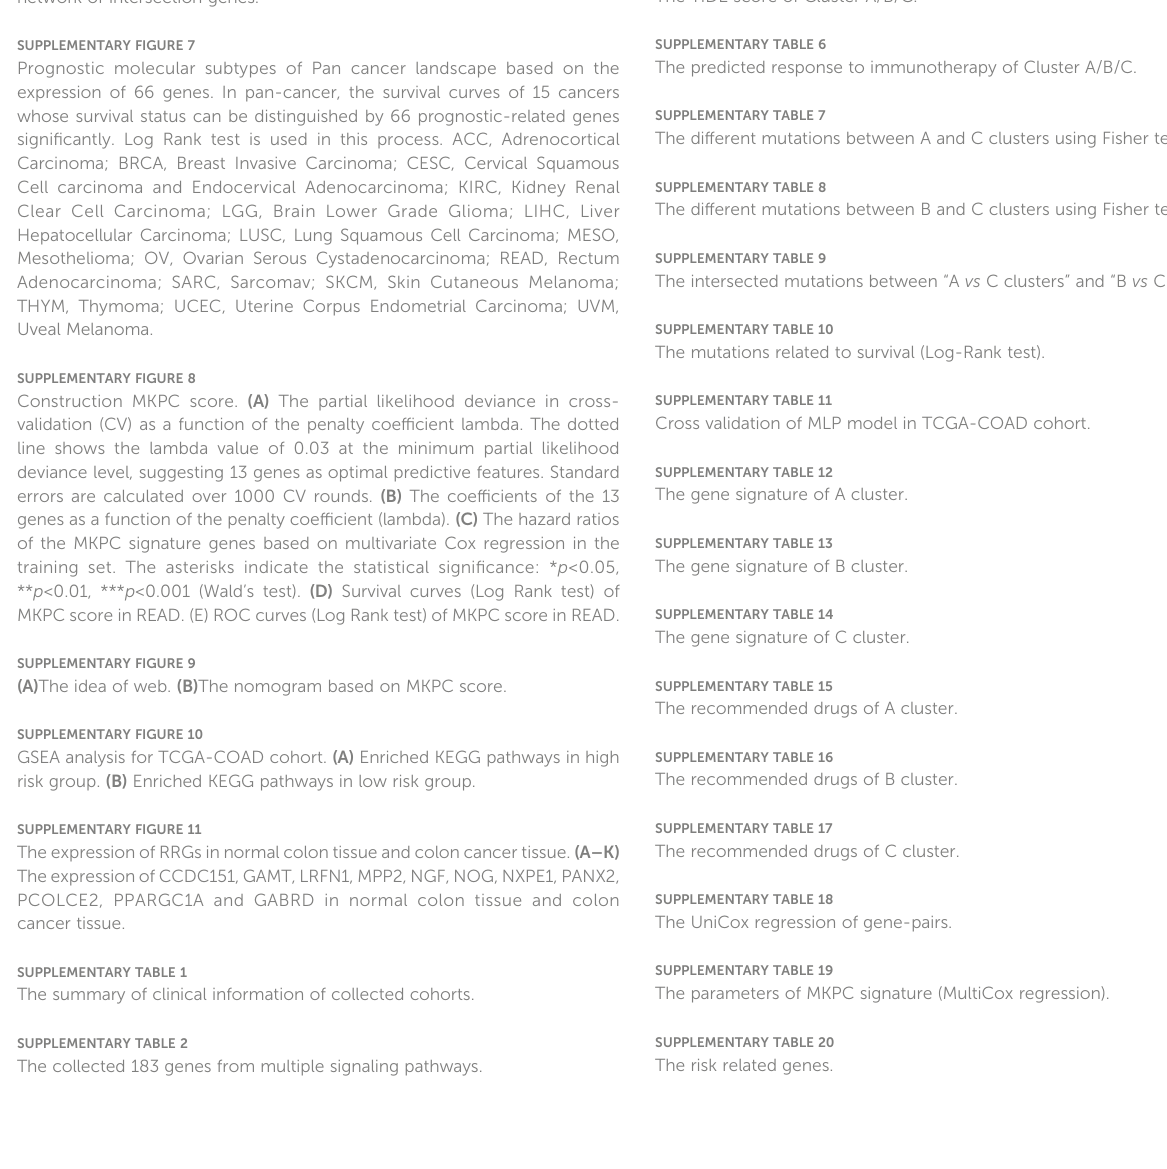
SUPPLEMENTARY TABLE 5 The TIDE score of Cluster A/B/C. SUPPLEMENTARY TABLE 6 The predicted response to immunotherapy of Cluster